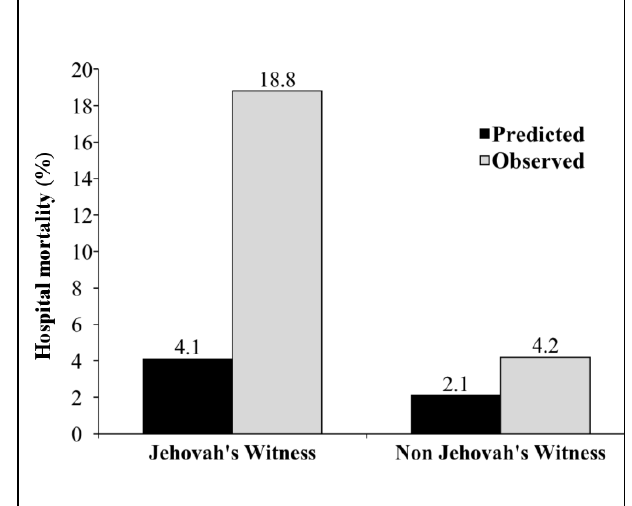
Fig. 1 - Comparison of the predicted and observed hospital mortality in JW and non-JW patients accordingly EuroSCORE